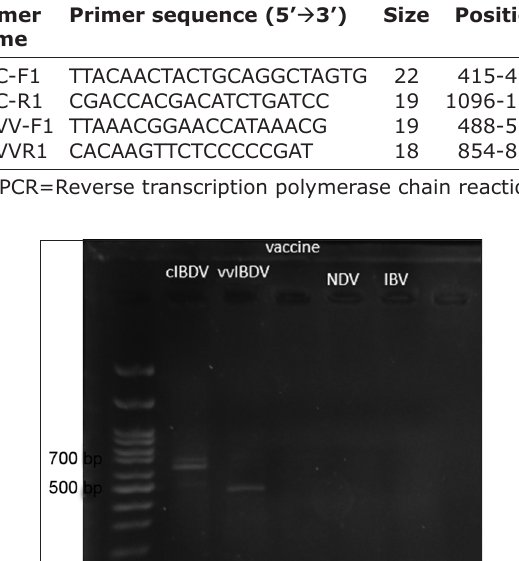
Table-4: Primers designed for multiplex RT-PCR. Primer